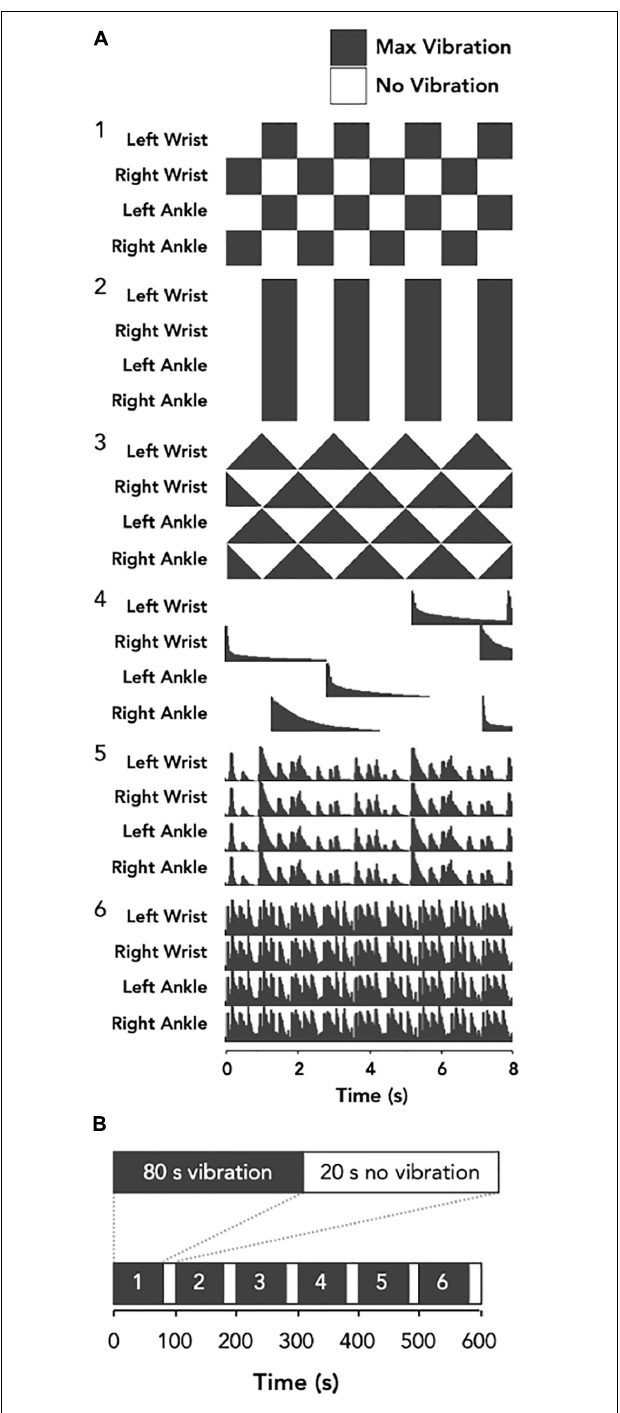
FIGURE 2 | Schematic representation of the vibrotactile stimulation protocol. The vibration patterns for the HA-P vibration trial (A) were three crafted waveforms; left-right oscillating (1), on-off oscillating (2), and sawtooth (3), and three audio extracted waveforms; random chimes (4), slow ternary monophonic music track (5), and fast electronic music track (6). Conversely, for the LA-C vibration trial the stimulus was constant (not shown). Each bout of vibration was delivered for 80 s with 20 s off-periods separating each bout (B)